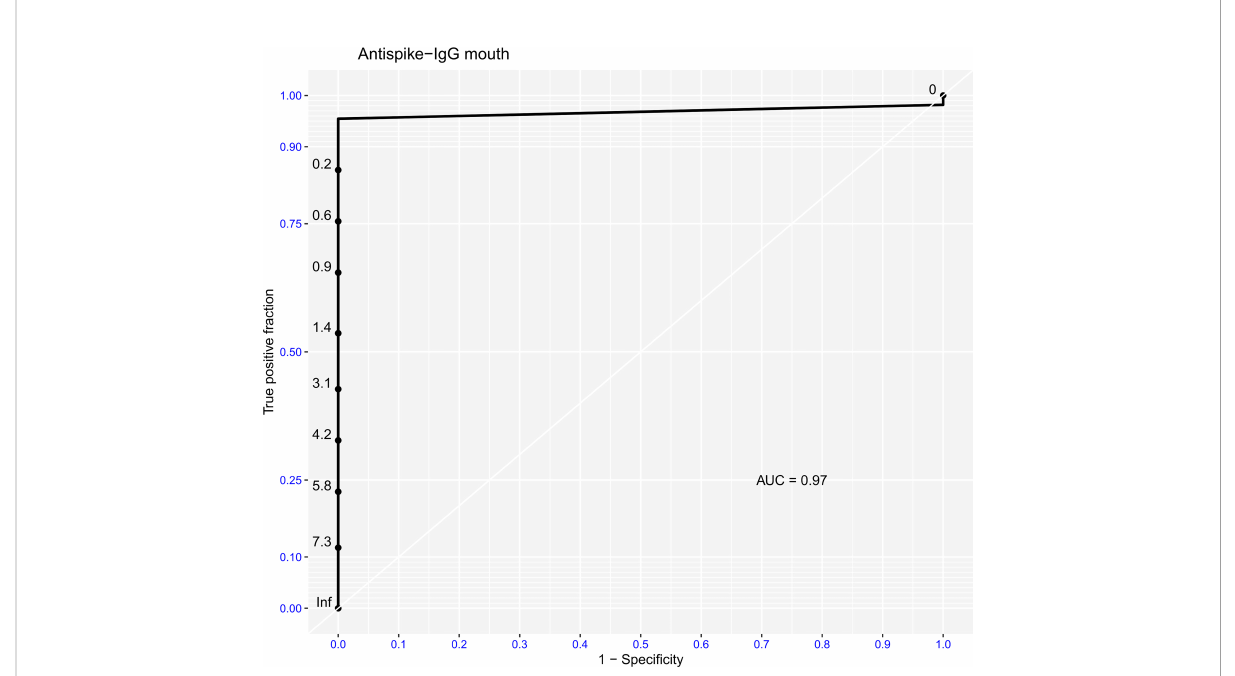
FIGURE 2 Graphical display of ROC analysis for optimal cutoff determination of the buccal swab assay with serum results serving as reference. The values of the y axis in black represent the respective OD cutoff values. The outer scale in blue represents the sensitivity while the values of the x axis in blue represent the 1-speci fi city with value 0.0 accounting for 100% speci fi city. The AUC was computed on account of the ROC